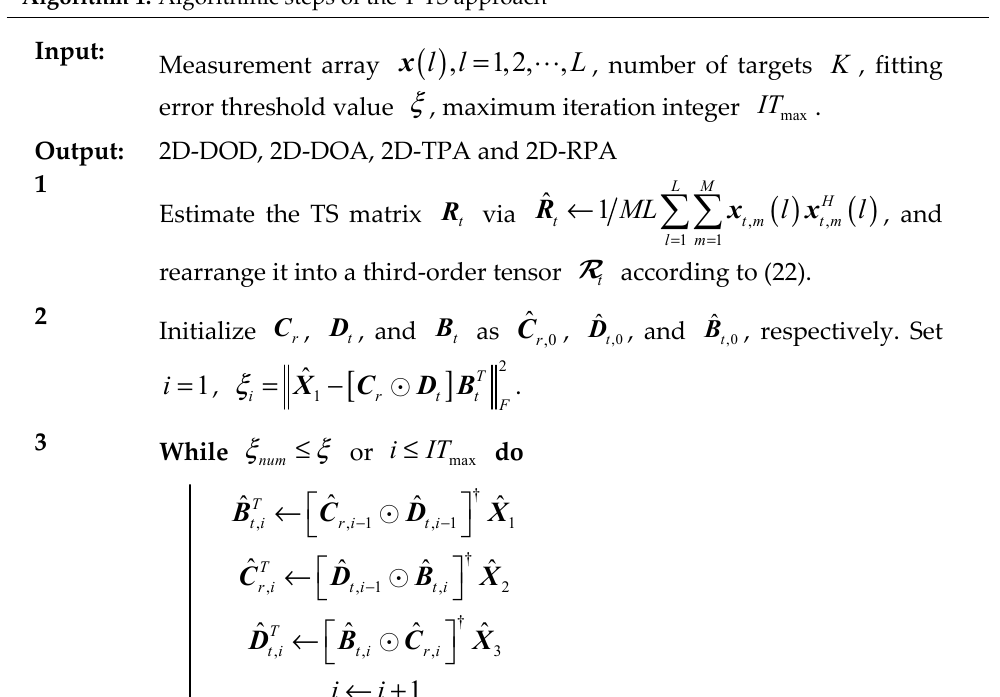
Algorithm 1: Algorithmic steps of the T-TS approach Algorithm 1: algorithmic steps of the T-TS